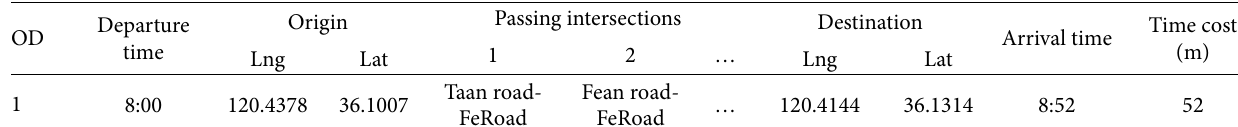
Table 2: Data sample of Baidu Maps Web API v2.0 for car travelers.